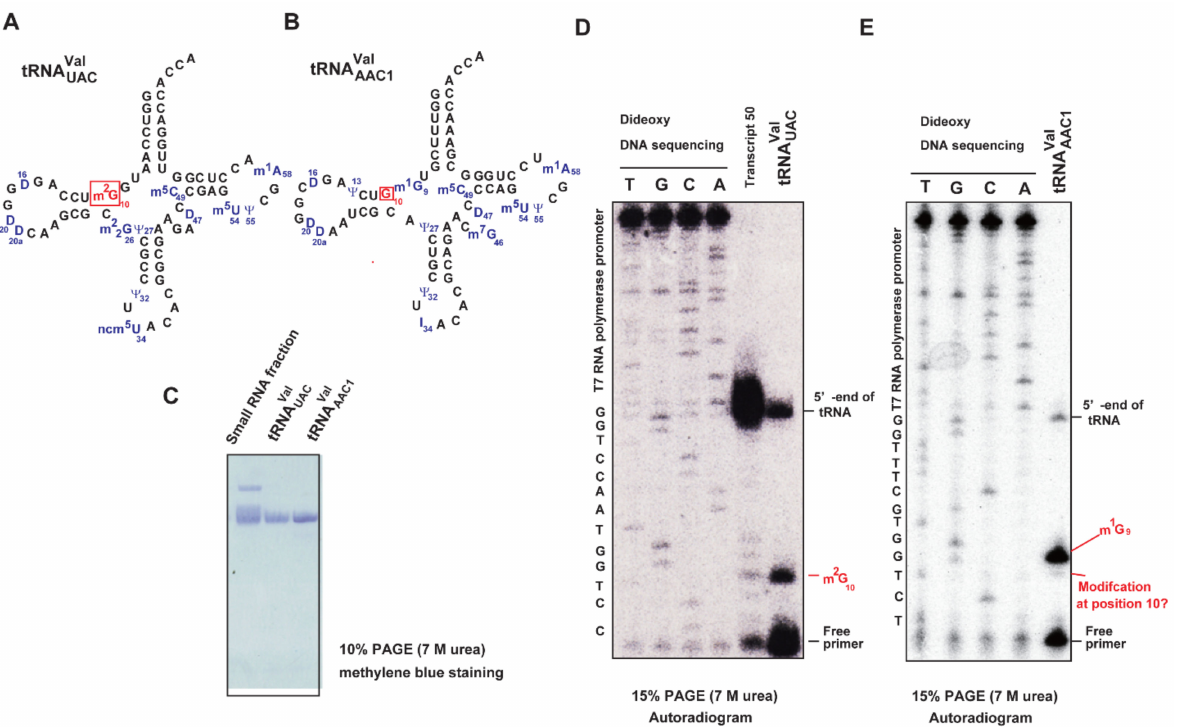
Figure 11. Primer extension experiments suggest that a portion of G10 in tRNA Val AAC1 is modified. ( A ) Cloverleaf structure of tRNA Val UAC . m 2 G10 and modified nucleosides are colored in red and blue, respectively. ( B ) Cloverleaf structure of tRNA Val AAC1 . G10 and modified nucleosides are colored in red and blue, respectively. ( C ) Purified tRNA Val UAC and tRNA Val AAC1 (0.05 A260 units each) were analyzed by 10% PAGE (7 M urea). The gel was stained with methylene blue. ( D ) Purified tRNA Val UAC was analyzed using the primer extension method. Because dideoxy DNA sequencing was preformed using the template DNA for transcript 50, the T7 RNA polymerase promoter region can be read in addition to the tRNA coding region. Transcript 50 was methylated by Trm11-Trm112 with non-radioisotope AdoMet and then used for the primer extension. The paused band derived from m 2 G10 is marked. ( E ) Purified tRNA Val AAC1 was analyzed using the primer extension method. In addition to the paused band derived from m 1 G9, a faint posed band is observed at position